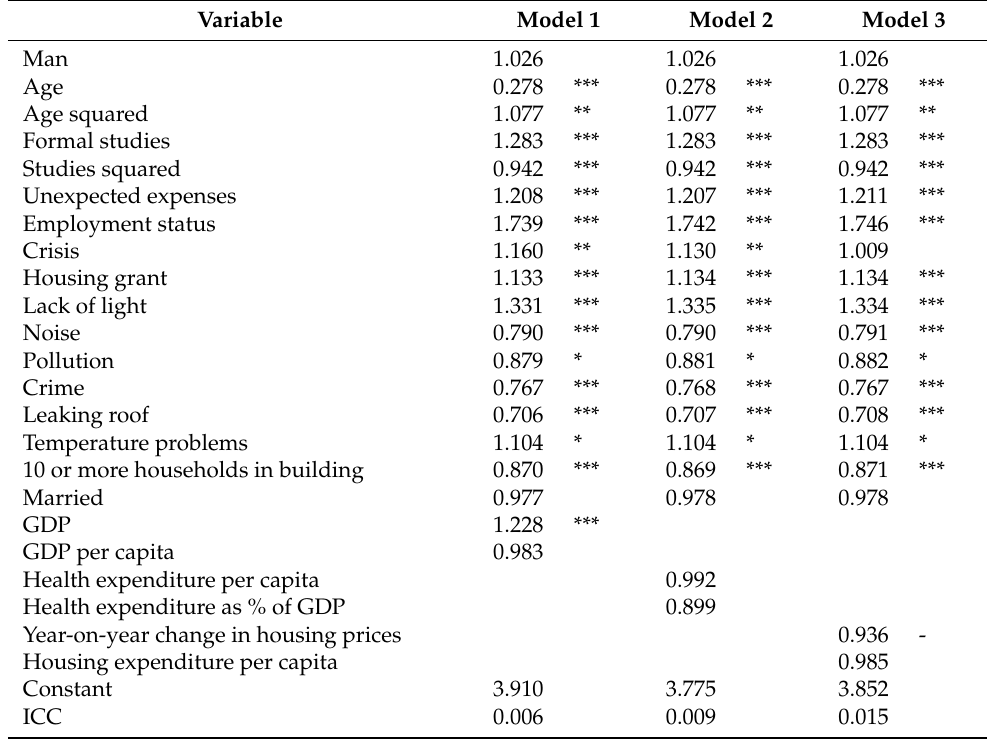
Table 3. Multilevel logistic regression models for the objective health